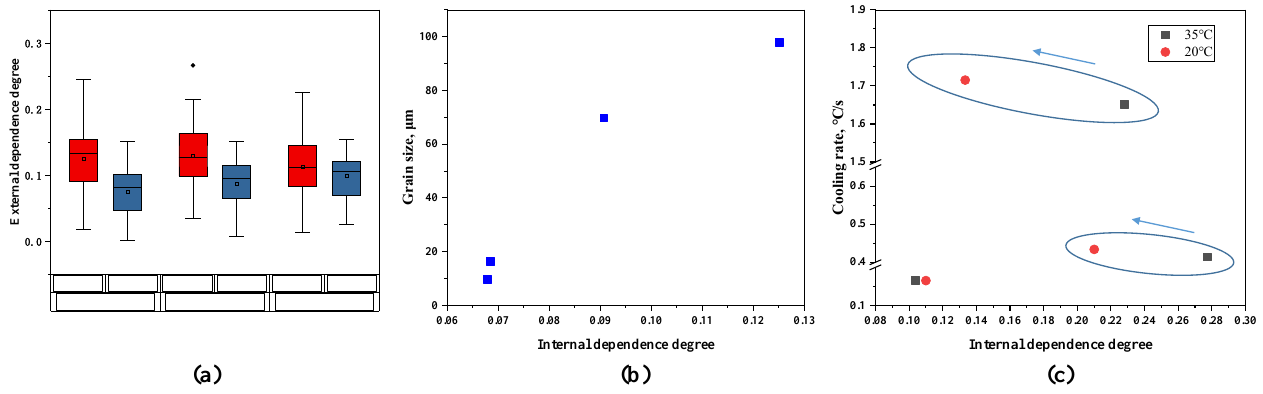
Figure 9. External dependence degrees in 3D printing samples and internal dependence degrees in 3D printing samples and CC billets. ( a ) External dependence degree among different areas in the 3D printing samples. C and E denote the columnar grain sample and the ultrafine equiaxed grain sample, respectively. A1-A2, A1-A3, and A2-A3 mean the correlations between three equal width areas in Figure 3. ( b ) The relationship between the grain size and the internal dependence degree in 3D printing samples of titanium alloys. ( c ) The relationship between cooling rate and the internal dependence degree in the CC